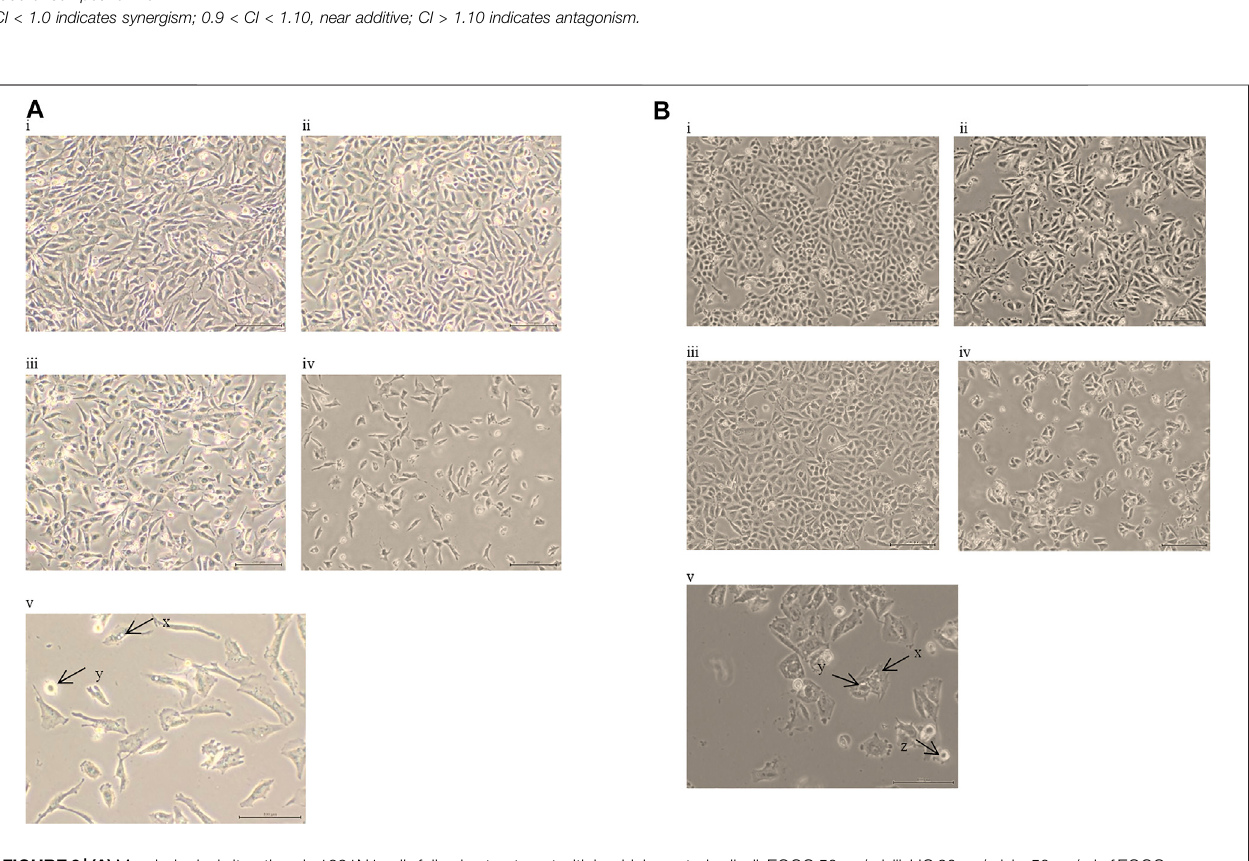
FIGURE2|(A) Morphologicalalterationsin1321N1cellsfollowingtreatmentwithi.vehiclecontrolcells,ii.EGCG50 µg/ml,iii.HC20 µg/ml,iv.50 µg/mlofEGCG+ 20 µg/ml of HC, v. scale 100 µm; 50 µg/ml of EGCG + 20 µg/ml of HC; for 24 h (40× magni fi cation). The arrows indicate; x. vacuolated cytoplasm and y. cell shrinkage; (B) MorphologicalalterationsinLN18cells followingtreatmentwithi. vehicle controlcells, ii.EGCG 50 µg/ml,iii. HC 10 µg/ml, iv.50 µg/mlofEGCG +10 µg/mlofHC,v. scale100µm;50 µg/mlofEGCG+10 µg/mlofHC;for24h(40×magni fi cation).Thearrowsindicate;x.vacuolatedcytoplasm,y.thecollapseofnucleus,andz.cell